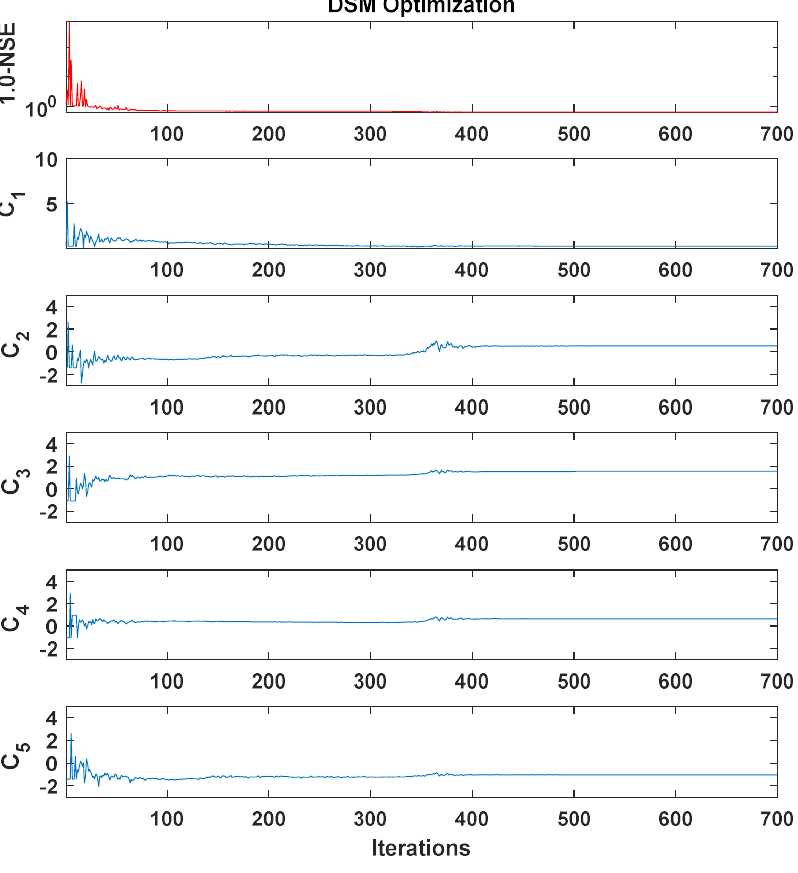
Figure 7. DSM optimization results for Equation (30) by minimizing 1.0−NSE (or maximizing NSE).